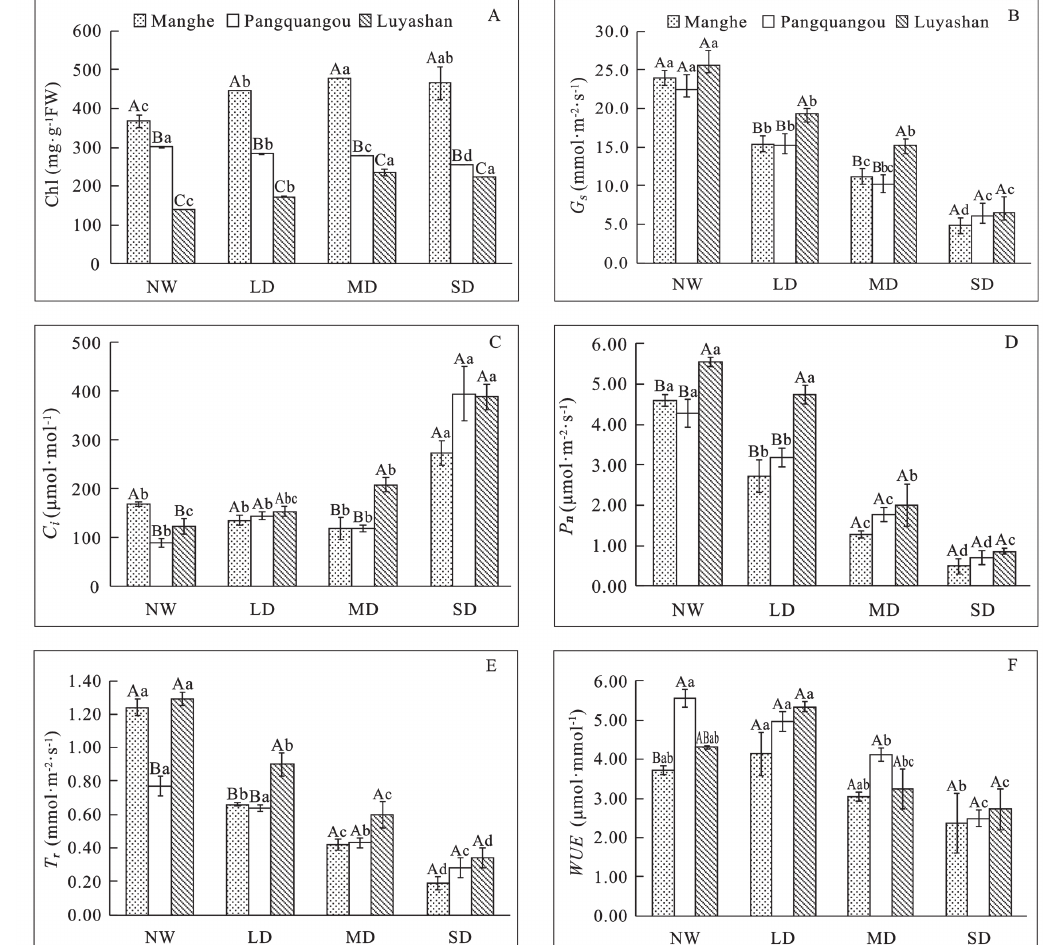
Fig. 4: Photosynthesis indexes of three provenances of Dioscorea nipponica Makino treated by four water regimes. Six indexes included Chlorophyll concentration (Chl, mg·g -1 FW), stomatal conductance ( G s , mmol·m -2 ·s -1 ); intercellular CO 2 concentration ( C i , μmol·mol -1 ); net photosynthetic rate ( P n , and Luyashan. Four water regimes involved normal-watered (NW, 70%-85% water holding capacity, WHC), light drought stress (LD, 55%-60% WHC), moderate drought stress (MD, 40%-45% WHC) and severe drought stress (SD, 20%-35% WHC). Different capital letters indicate significant difference among three provenances at P < 0.05; Different lower-case letters indicate significant difference among four water regimes at P <